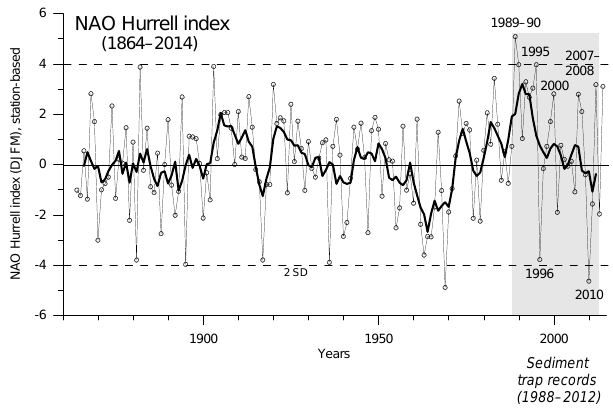
Figure 2. The NAO Hurrell index (DJFM, station-based, Lisbon- Rejkjavik, Hurrell, 1995) plotted from 1864–2014. Grey shading indicates the time period covered by the long-term flux record off Cape Blanc, Mauritania. A 5-point running mean is shown by the thick